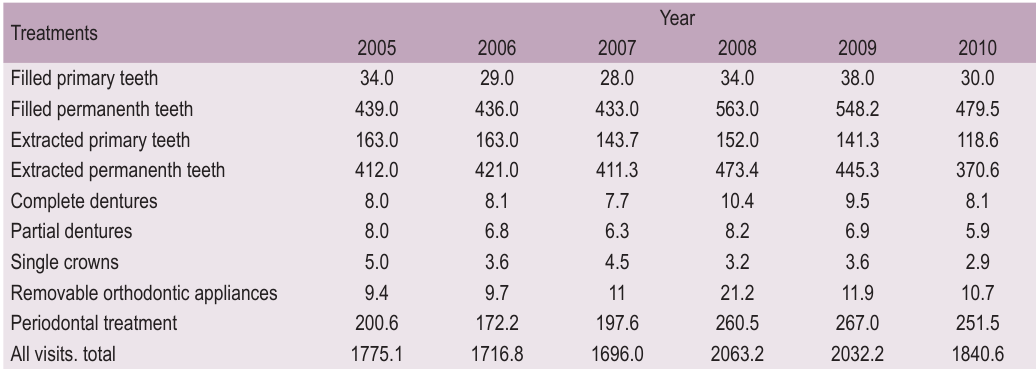
TABLE 3. Number of visits and performed treatments per doctor of dental medicine in public dental service during the time period year 2005 to 2010.